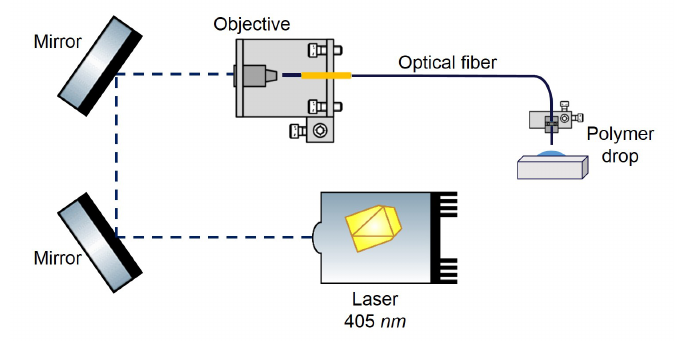
Figure 1. Scheme of the optical setup used to couple the 405 nm laser used to polymerize the micro structures on the optical fiber tips.